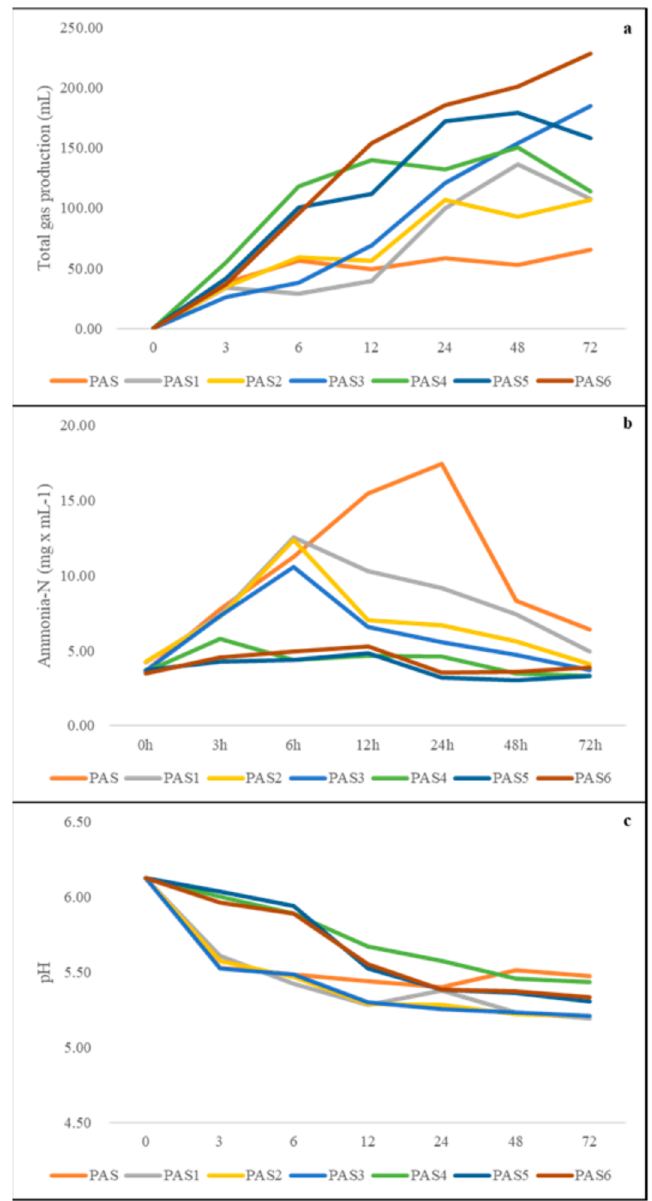
Figure 1. Total gas production ( a ), ammonia-N concentration ( b ), and pH values ( c ) of pineapple waste silage supplemented with or without proteolytic